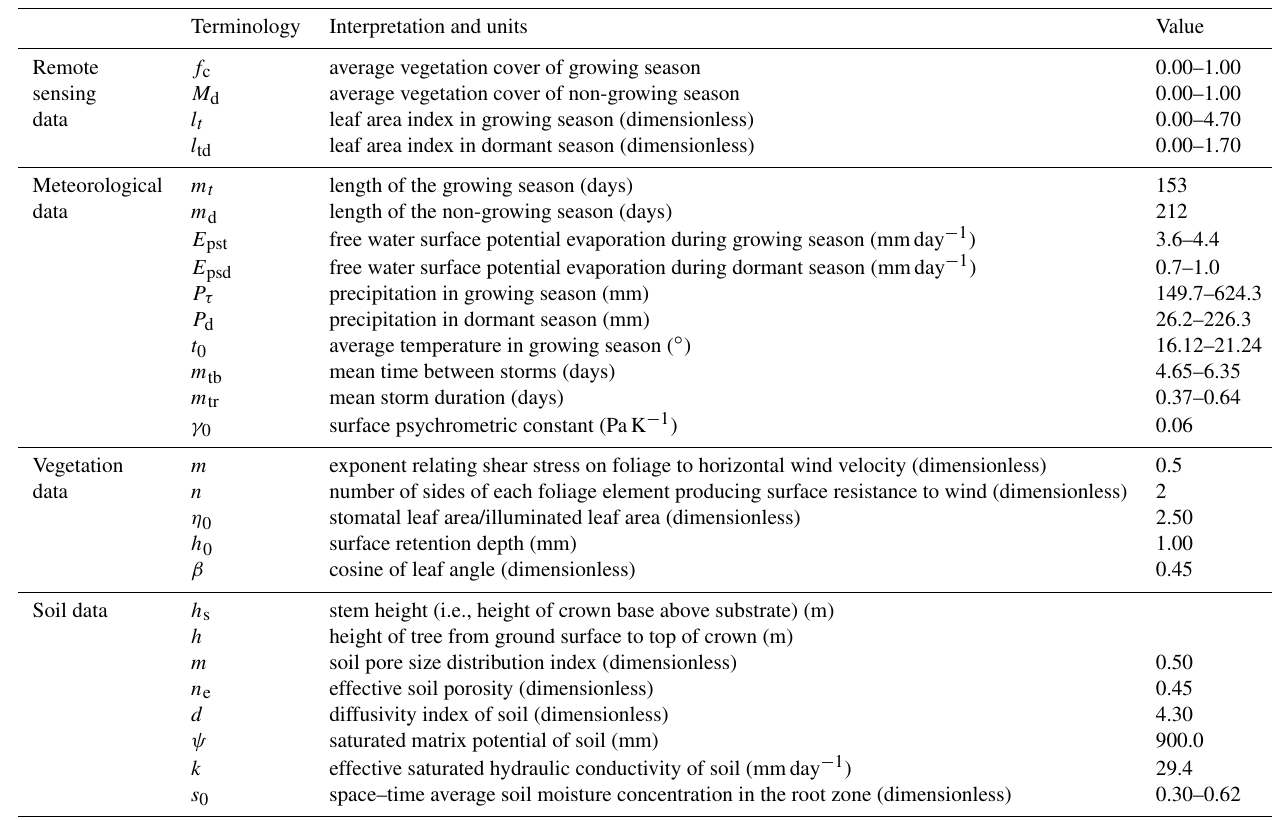
Table 1. The terminology, interpretation, units and values of